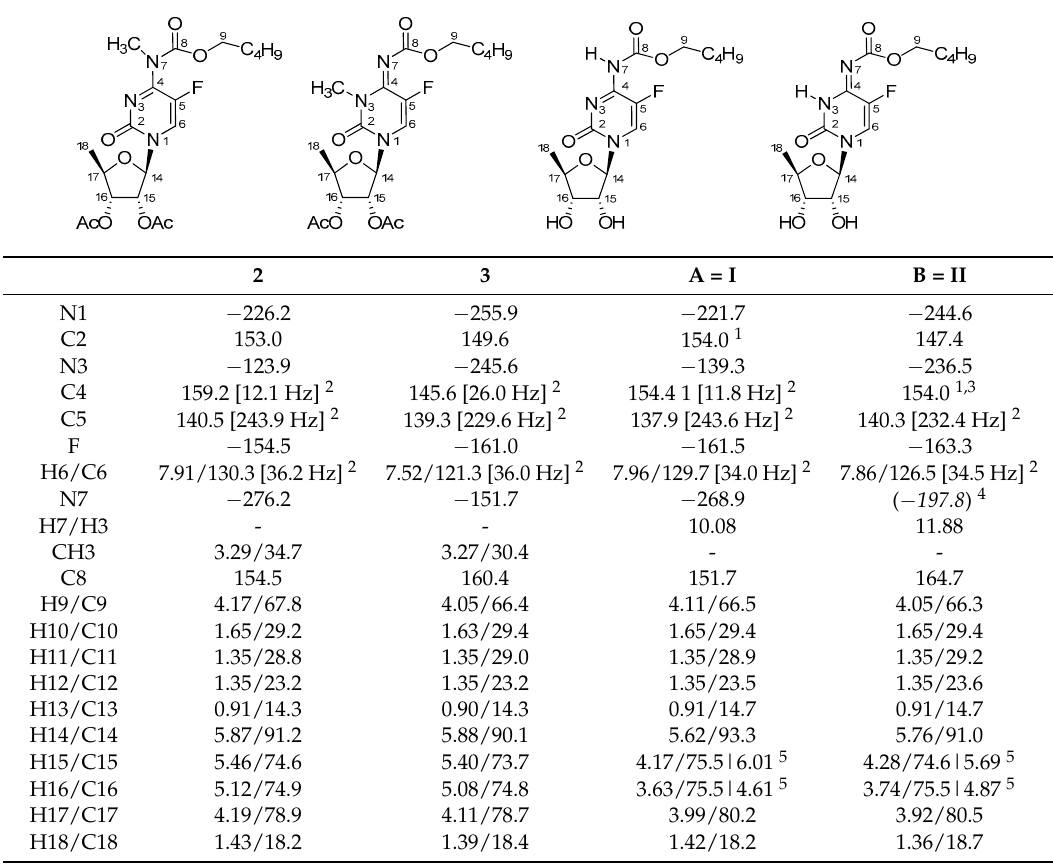
Molecules 2018 , 23 , 161 6 of 14 Table 2. The 1 H-, 13 C-, 19 F- and 15 N-NMR chemical shifts in THF- d 8 for the tautomeric forms of capecitabine 1 (at 218 K) and its methyl derivatives 2 and 3 (at 298 K).